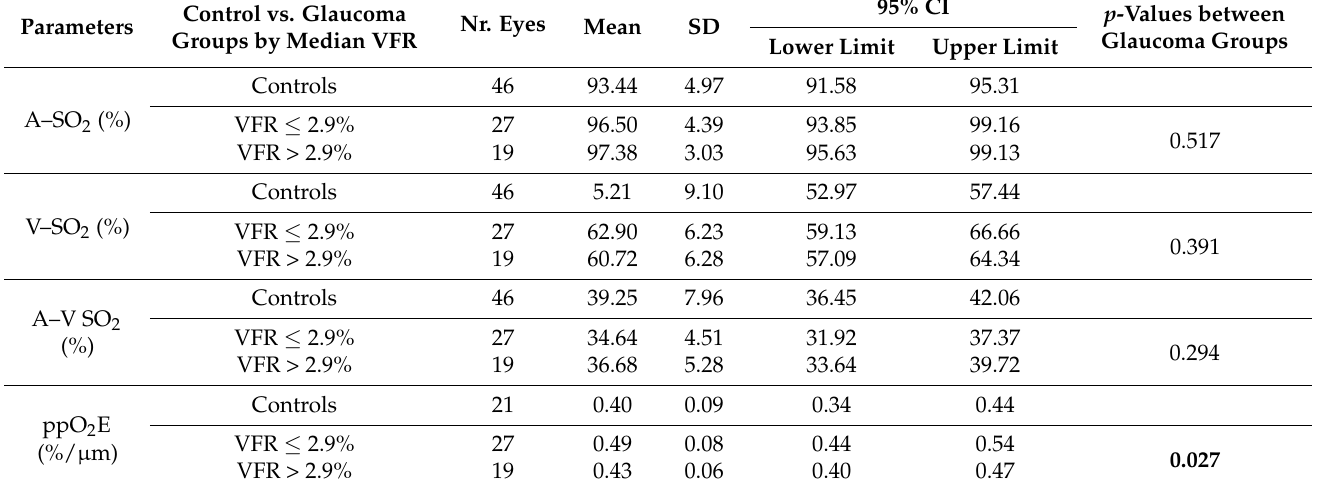
Table 2. Oxygen saturation and peripapillary oxygen exposure values in glaucoma patients in groups. Based on the median VFR glaucoma subjects were divided in two groups: VFR group with ≤ 2.9% VFR dilatation from the baseline diameter and the VFR group with >2.9% VFR dilatation from the baseline diameter. The respective oxygen saturation and peripapillary oxygen exposure values of controls are given for comparison. Statistically significant values ( p < 0.05) are given in